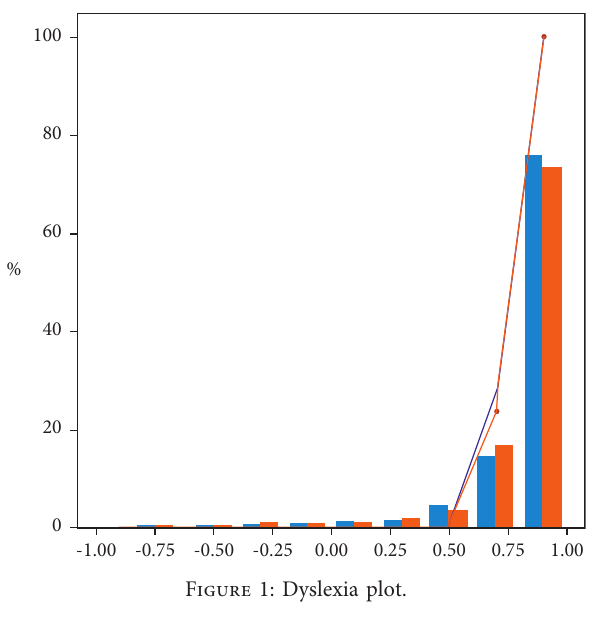
Figure 1: Dyslexia plot.